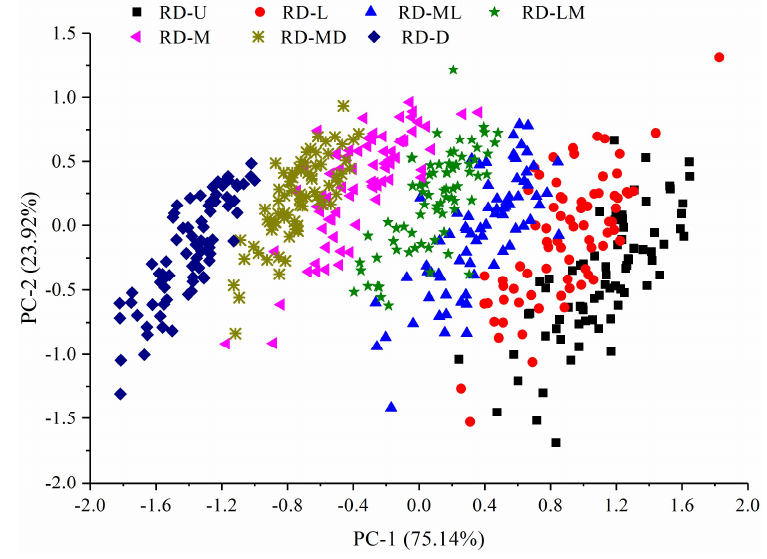
Figure 5. The score plot of first two principal components (PCs) of the seven roasting degrees of the coffee beans. RD-U: unroasted; RD-L: light; RD-ML: moderately light; RD-LM: light medium; RD-M: medium; RD-MD: moderately dark; and RD-D: dark.